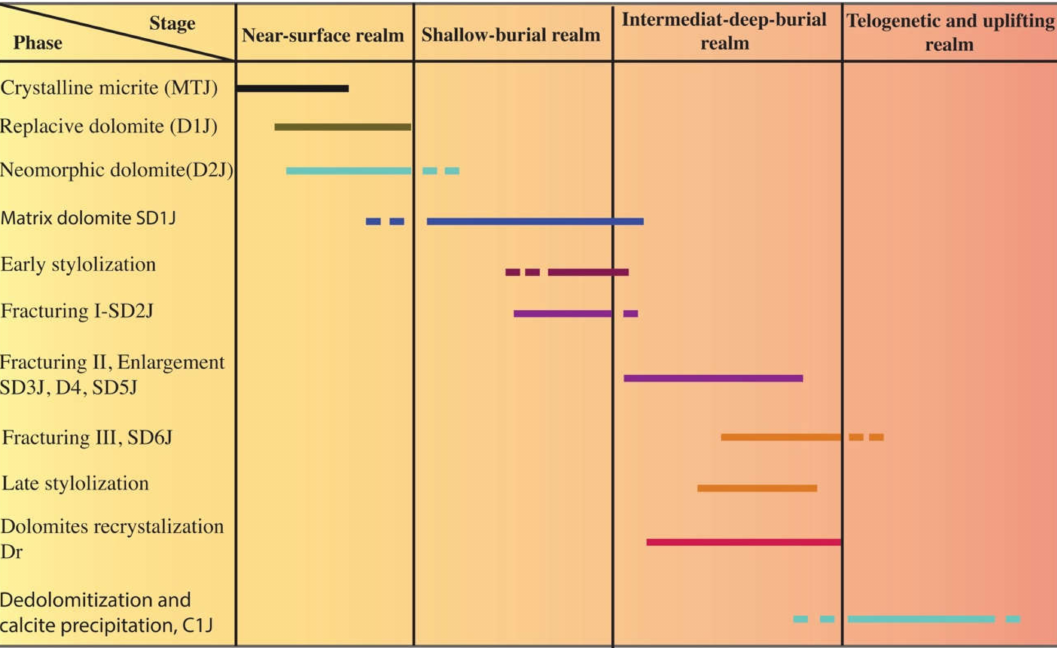
Figure 12. ParageneticsuccessionillustratingthediageneticphasesofJurassicsection. ProvençalDomain, SE France (see text for